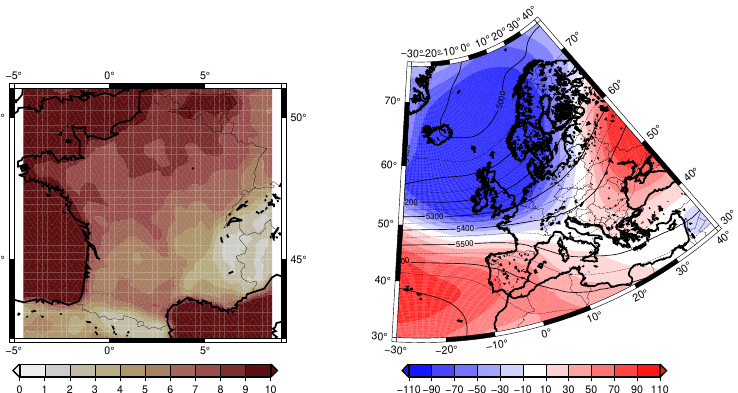
Figure 8. Left panel : mean maximum daily wind speed (in m/s) over France between 6 December 2019 and 15 December 2019. Right panel : mean anomalies of Z500 with respect to the seasonal cycle (in m) over the East North Atlantic region (colours). Contour lines indicate the mean Z500 (in m). This spate of storms also brought a lot of precipitation over France, and caused local